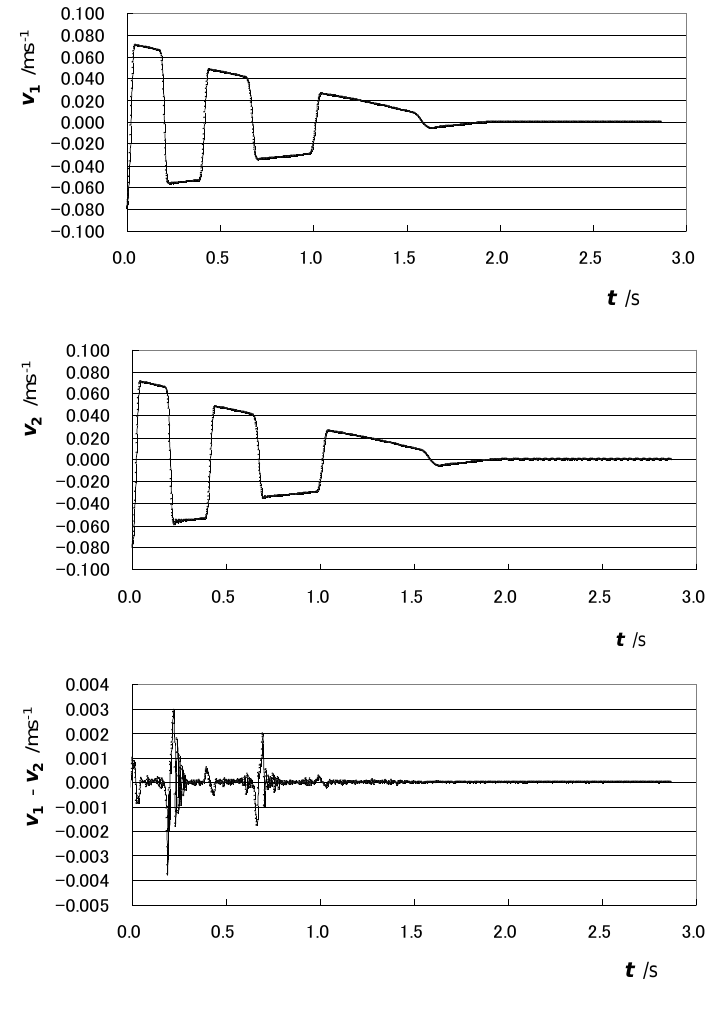
Figure 3. Change in velocities at CC1 and